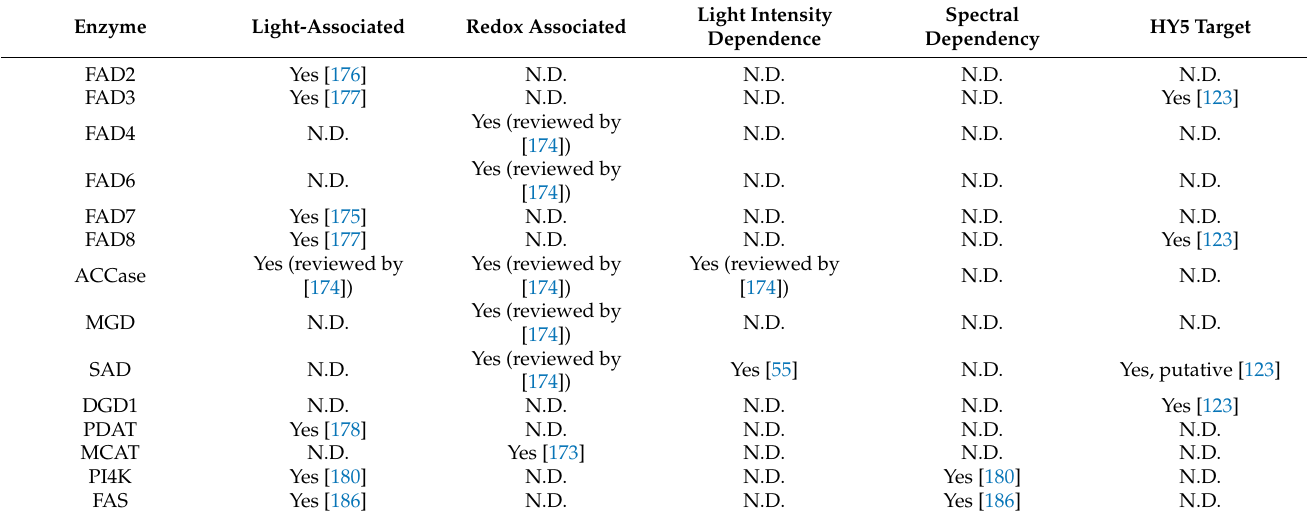
Table A2. Light and/or redox associated regulation of certain enzymes (or genes) involved in lipid biosynthesis.